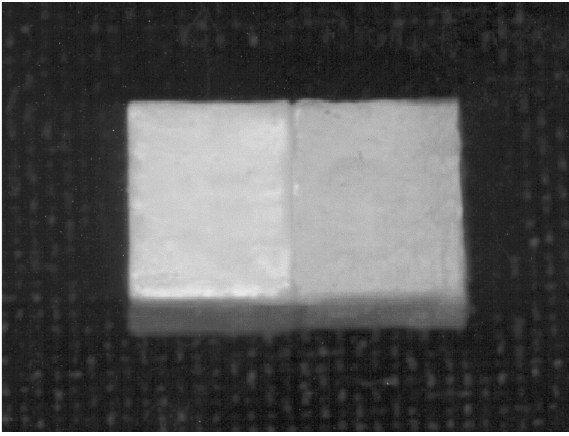
FIGURE 3- Sample constituted by ceramic and resin block after cementation